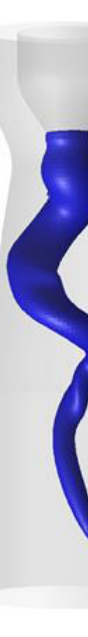
Fig. 8. Snapshot of the instantaneous pressure field visualizing the pressure contour of the vortex